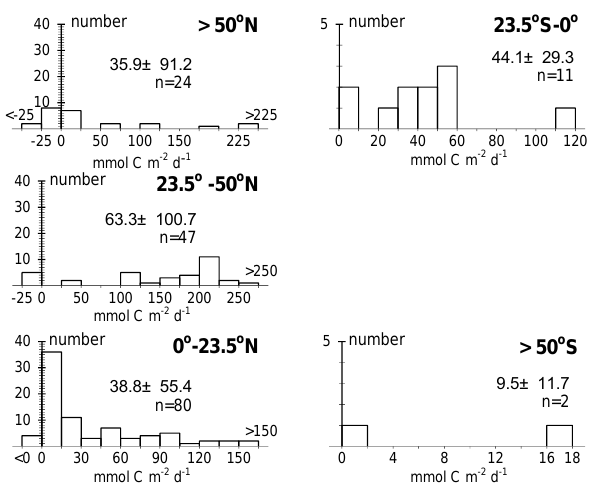
1 Figure 4. Histogram of reported annual CO 2 fluxes of world's estuaries in various latitude bands. 2 3 Fig. 4. Histogram of reported annual CO tuaries in various latitude